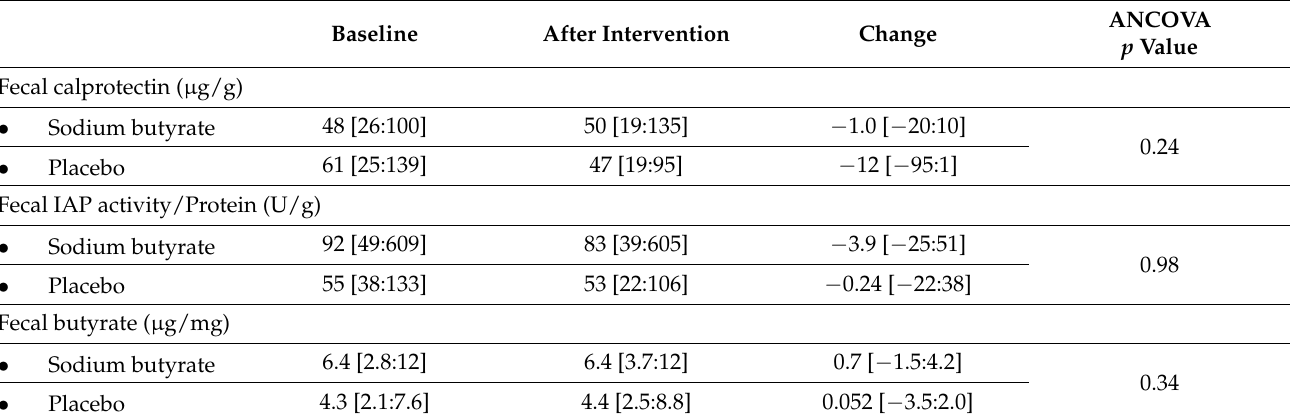
Table 2. Change in fecal, blood, urinary markers and HbA1c after 12 weeks intervention,